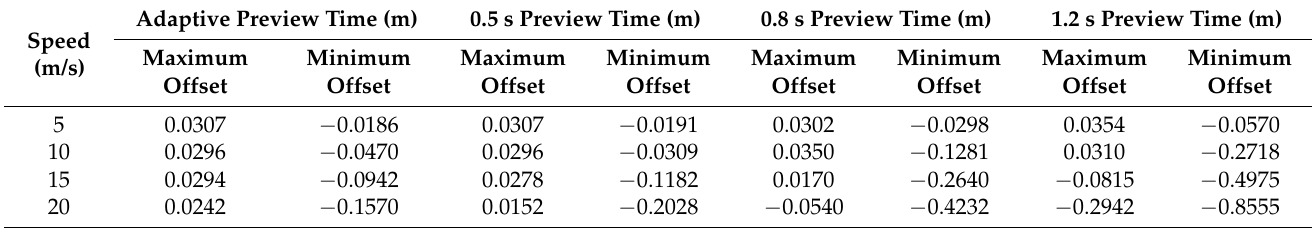
Table 6. Maximum offsets and minimum offsets for different preview times and different speeds for road segment